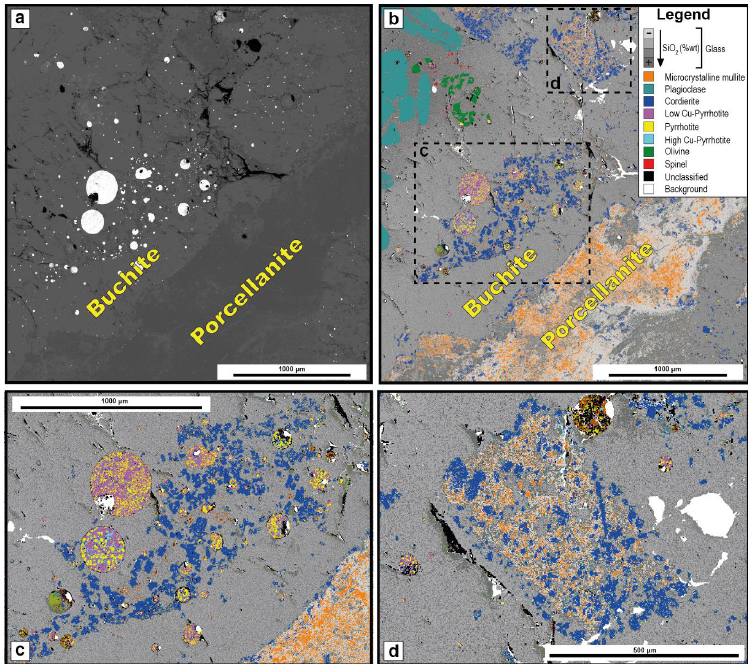
Figure 7. Backscatter FESEM image with the bright sulphide globules in the buchite portion ( a ); QEMSCAN TM map (step size of one pixel to the other is 1.3 μm) of the B1 porcellanite–buchite composite xenolith ( b ); close–up of the QEMSCAN TM map (buchite portions): sulphide globules (pyrrhotite, Low-Cu pyrrhotite and High-Cu pyrrhotite) ( c ); pseudomorphic clinopyroxene of the early protolith of the xenoliths mainly replaced by cordierite and mullite ( d ). For abundance and size distribution of the sulphide globules, see also X-ray μCT scan data in Figure 8a and presented in the Supplementary Material (Video S1, Table S1). Pyrrhotite, low-Cu pyrrhotite and high-Cu pyrrhotite occur together within the sul- phide globules (close-up of Figure 7c). In detail, they consist of a three-composite phase of cupriferous Fe–S containing, respectively, 1–4, 8–9 and 21–30 mole% Cu. Element map- ping data integrated over the two-dimensional cross section of the larger globules gives 10.5 mole% Cu and 39.5 mole% Fe that may be taken as a first estimate of the unmixed original globule composition. Zinc is the only other significant element up to 1 mole%. Some globules are embayed with irregular coatings containing Pb and As sulphide. Un- mixing of the sulphide phases to grain sizes less than laser–ablation spot size (20 μm) precluded use of this method to quantify the partitioning of metals between the globules and the surrounding glass. The abundance of sulphide globules is not fully expressed in a 2D polished section due to steric effects (Figure 8a) but becomes very clear in a video of the X-ray μCT scan of 3D data (Video S1). The ternary sulphide phase diagram (Figure 8b) suggests that, for an initial sulphide molar composition of Cu:Fe:S = 10.5:39.6:49.9 mole% such as that found for some of the Cu–pyrrhotite, the globule temperature was close to 1000 °C. Following the experimental data of Vaughan and Craig [83] for the Cu–Fe–S system (Figure 8b) at 700 °C, melts are entirely quenched to an exsolution assemblage comprising an intermediate solid solution phase (ISS) and chalcopyrite (ccp) and other phases close to CuFeS 2 and a solid solution